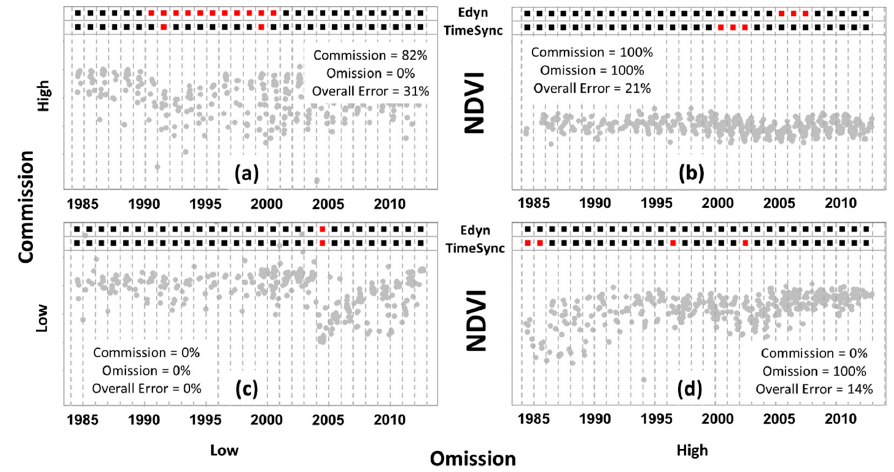
Figure 7. Commission and omission errors for Edyn against the TimeSync reference data, for four example pixels. NDVI (gray) time series and disturbance (red)/non-disturbance (black) signals are given for each, with Edyn above the corresponding TimeSync signals. Error rates are given as well. ( a ) High commission and low omission; ( b ) high commission and high omission; ( c ) low commission and low omission; ( d ) low commission and high omission.